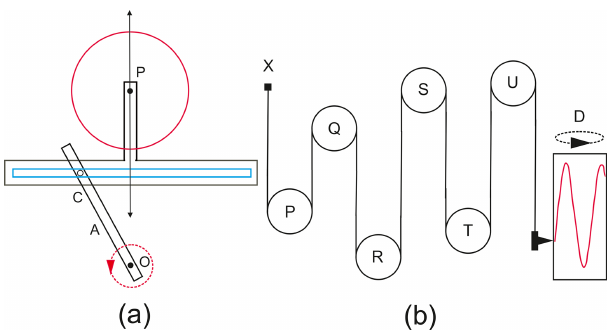
Figure 2. Schematic figure of a TPM based on drawings in Doo- dson and Warburg (1941). (a) A method for producing vertical si- nusoidal motion corresponding to that of one tidal constituent and (b) a method for summing six constituents with the use of a band wrapping around each pulley. See the text for further explanation.